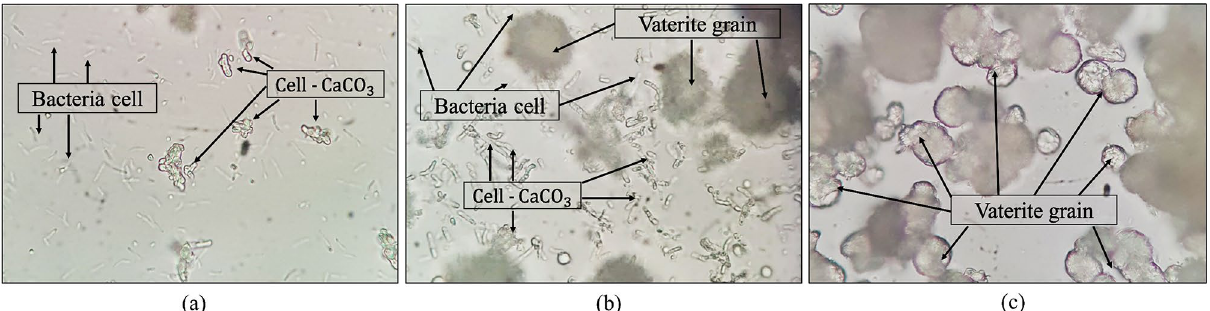
Figure 7. The optical microscope observation of the CaCO 3 precipitation with time for the FS composition: after ( a ) 24, ( b ) 48, and ( c ) 72 h.